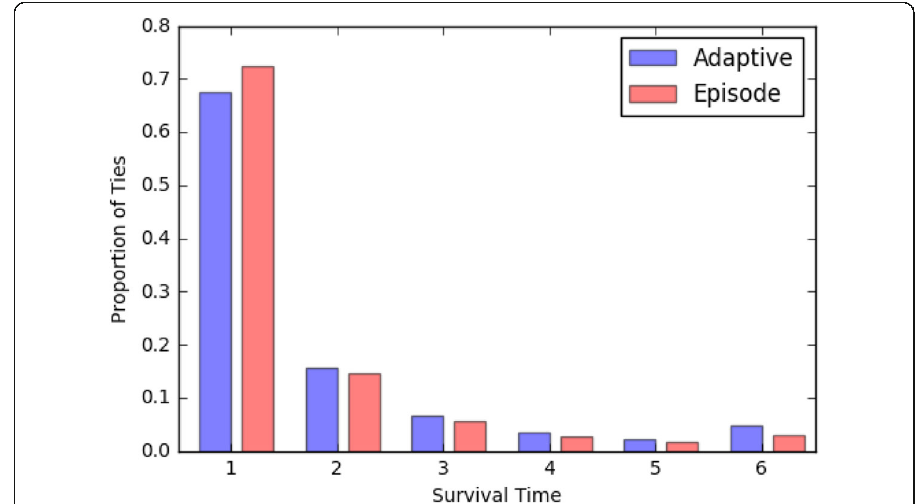
Fig. 2 Distribution of tie survival times for patient-based adaptive networks and episode-based networks (no thresholding), the two of the three approaches studied that result in networks with the same number of edges, making them directly comparable to one another. Proportion of surviving ties would be expected to decrease for survival times 1 – 5. Ties that have survival times equal to 6 survive throughout the studied